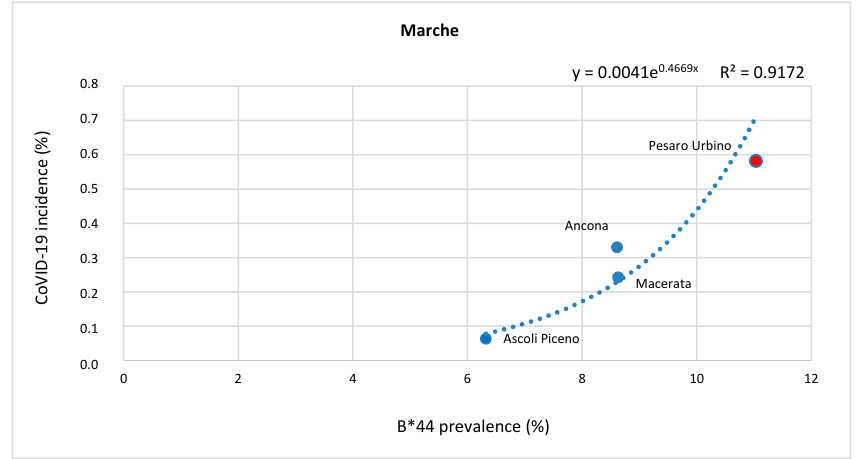
Figure 3. Correlation between COVID-19 incidence rate and HLA-B*44 prevalence in Emilia Romagna and Marche provinces. The graphs show the correlation between COVID-19 incidence and the prevalence of HLA-B*44 prevalence, both expressed as percentages, for all the provinces of Emilia Romagna (top panel) and all the available provinces of Marche (bottom panel). For each correlation, the R-squared value is provided at the top of the graph along with the estimated regression equations. For Emilia Romagna: r=0.681 and p -value=0.0628; for Marche r=0.958 and p -value=0.0423.